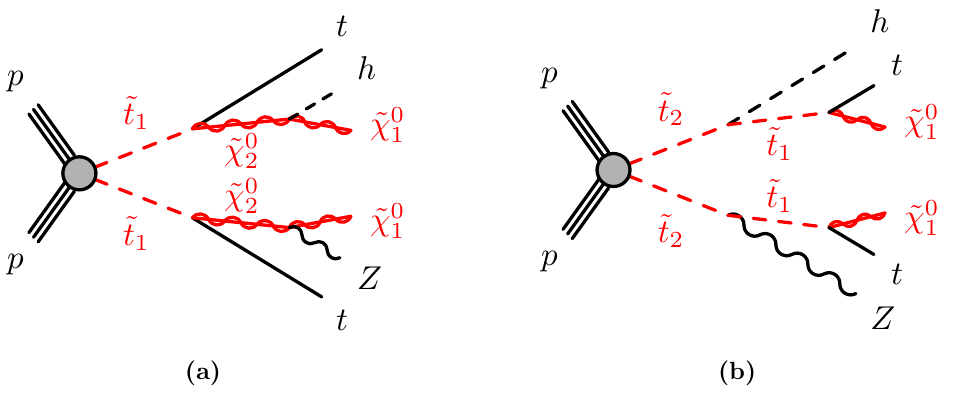
Figure 1. Diagrams for the top squark pair production processes considered in this analysis: (a) ~ t ! t ~ (cid:31) 0 2 and ~ (cid:31) 0 2 ! h=Z ~ (cid:31) 0 1 decays, and (b) ~ t 1